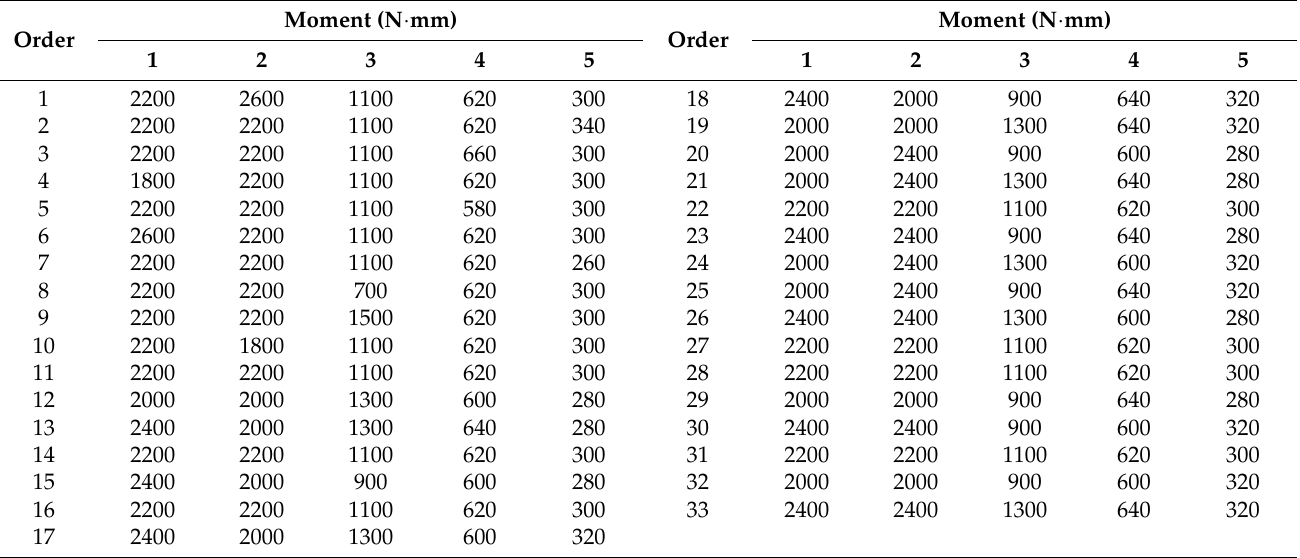
Table 2. Center composite design experimental data design of excitation